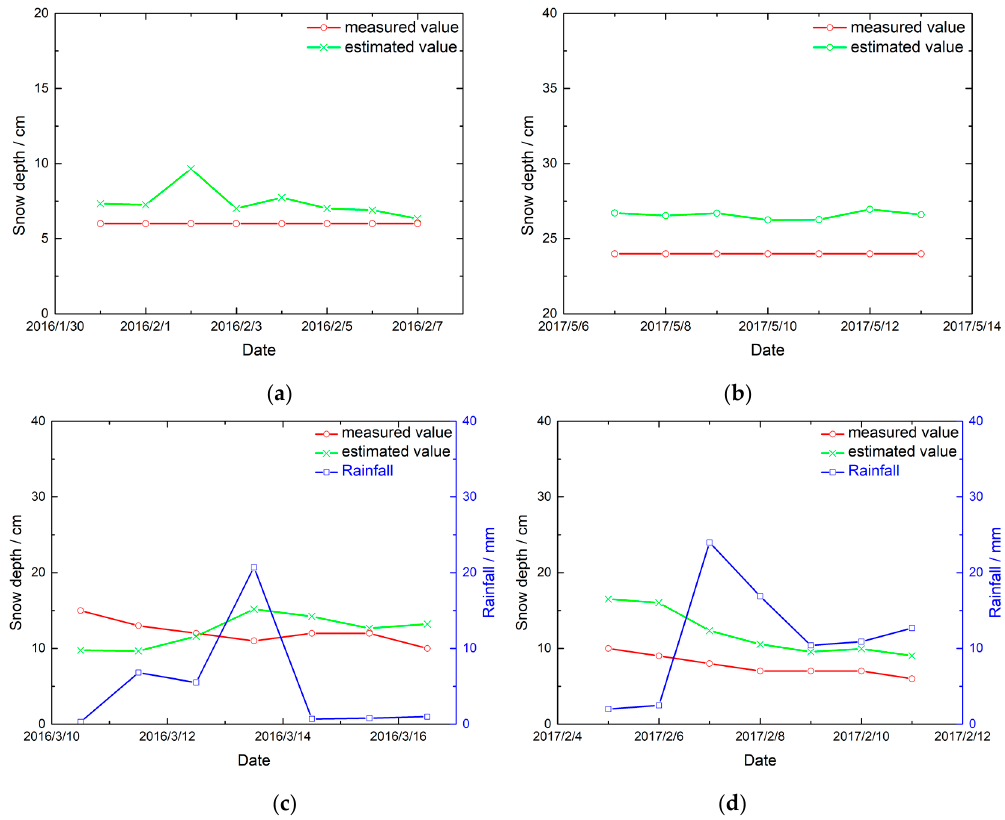
Figure 10. Estimated snow depths in situations with ( a and b ) and without ( c and d ) rainfall. Red and green lines represent the measured and estimated snow depths, respectively. Blue lines denote the amounts of rainfall during this period. Table 4. Statistical results for estimated snow depths with respect to in-situ snow depth in situations with and without rainfall.